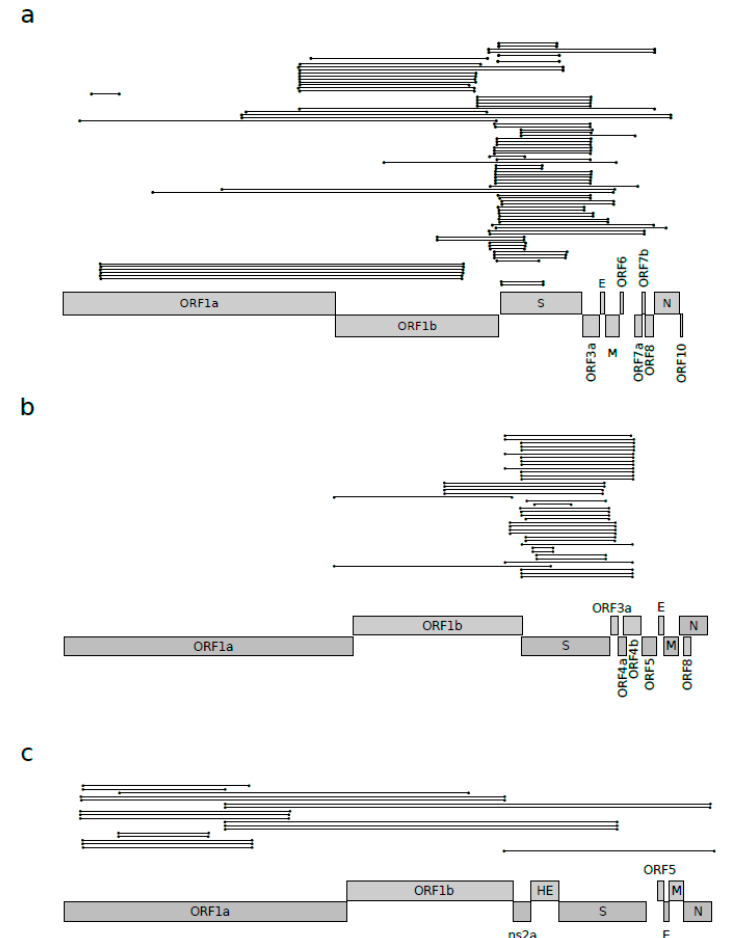
Figure 1. Recombination events in Betacoronavirus subgenera. Unique recombination events identified by 3SEQ in ( a ) sarbecovirus, ( b ) merbecovirus, and ( c ) embecovirus alignments. Each recombination event is shown as a line with dots representing the start and the end. Unique events were defined as those having exactly the same breakpoint positions. Schematic representations of ORF positions are also reported for SARS-CoV-2 in panel a , MERS-CoV in panel b , and HCoV-OC43 in panel c